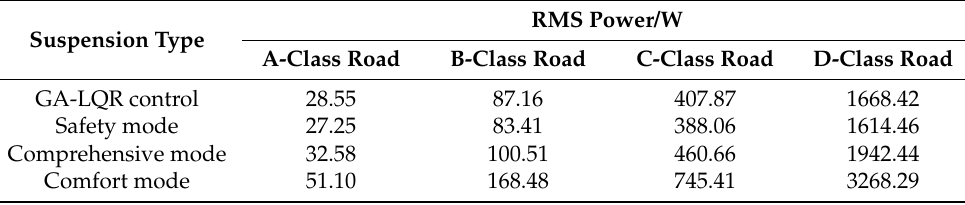
Table 12. RMS values of power consumption of each suspension type under different roads.